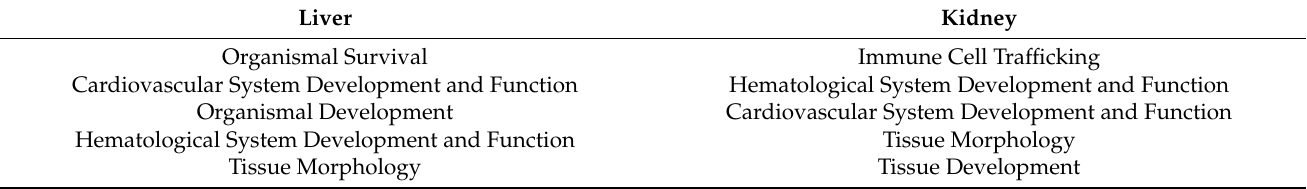
Table 7. Biological function list of differentially expressed genes from ifosfamide-treated liver and kidney. Liver Kidney Organismal Survival Immune Cell Trafficking Cardiovascular System Development and Function Hematological System Development and Function Organismal Development Cardiovascular System Development and Function Hematological System Development and Function Tissue Morphology Tissue